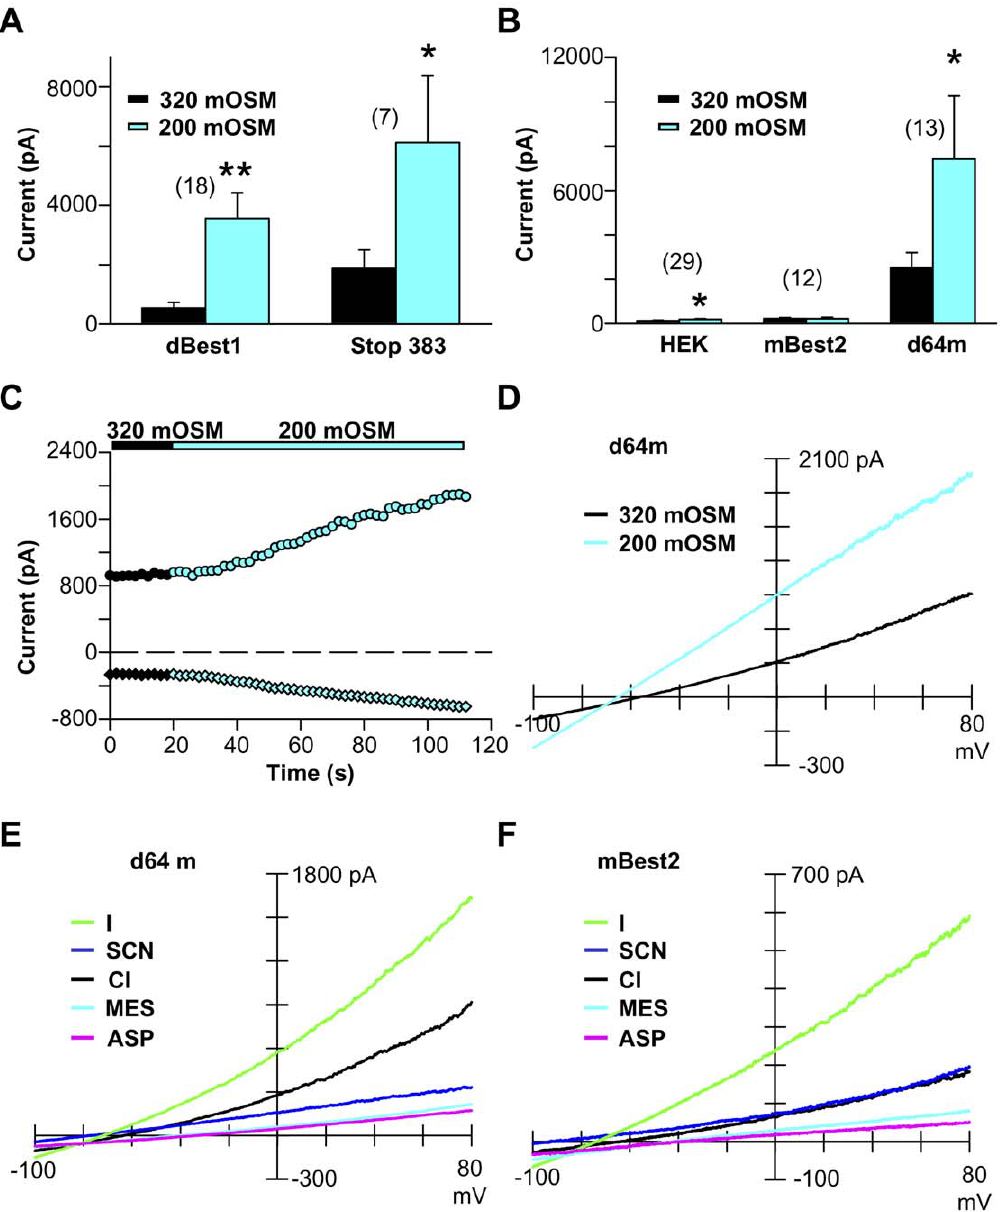
Figure 8. Chimeras between dBest1 and mBest2 confer swell activation on mBest2. ( A ) Truncation of dBest1 does not interfere with swell sensitivity. Constitutive currents are apparent with both dBest1 and Stop 383 overexpression in iso-osmotic solutions (320 mOSM). With swell, current increased dramatically for both constructs (Student’s t-test, * p , 0.05, ** p , 0.005). ( B ) d94m current increases significantly within the first 2 min of swelling (* Student’s t-test, p , 0.05). ( C ) Time course for d64m swell activation. ( D ) Current-voltage relations for constitutive d64m, and following 2 min 200 mOSM solution. ( E ) Selectivity sequence for the constitutively active d64m current. ( F ) Selectivity sequence for the constitutively active mBest2